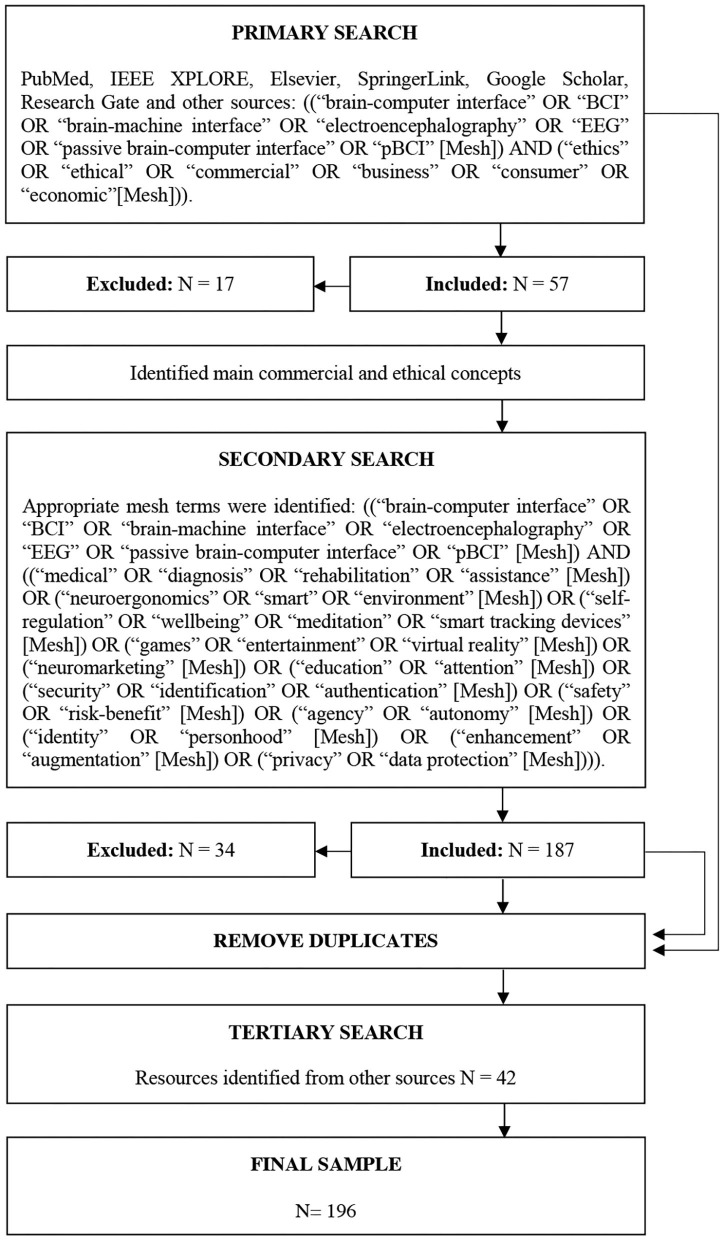
Search strategy.